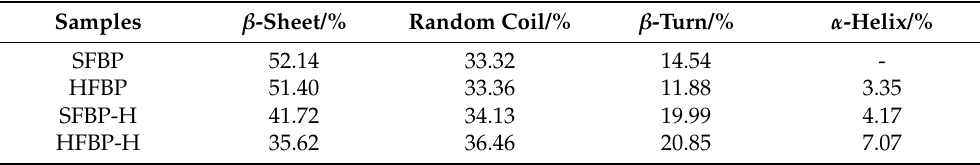
Table 2. The relative contents of the secondary structure (%) of fish bone protein before and after enzymatic